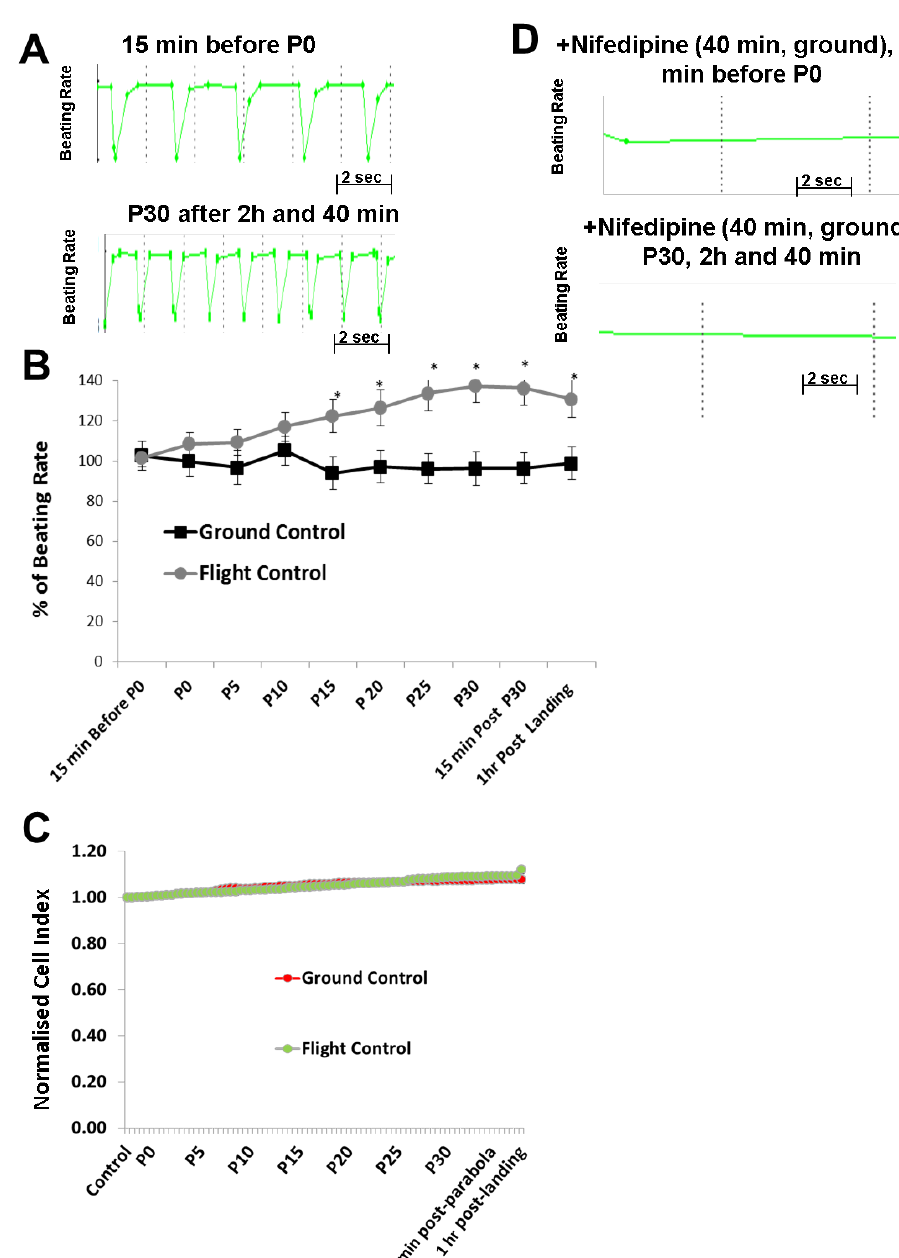
Figure 2. Analysis of the beating rate (BR) of human cardiomyocytes (hCMs) during parabolic flights. ( A ) Representative BR pattern of hCMs at a timepoint 15 min (1 g ) before starting the first parabola (P0) and after 31 parabolas (P30). ( B ) Data from three independent parabolic flight experiments (each executed in triplicate), as well as data collected from the 1 g ground experiment carried out in parallel. The BR values were normalized by setting the control pre-parabola flight or the ground control value to 100% (mean ± SEM; n = 9, * p < 0.05 for control versus parabolic flight experiment values). ( C ) Parallel monitoring of the cell viability expressed as cell index (CI) values. The CI values were normalized by setting the control values to 1. ( D ) Representative BR patterns of hCMs treated on the ground (1 g ) with nifedipine (1 µ M) 40 min before starting P0 and after P30. In this case, no BR was observed before P0 or after P30 because of complete inhibition of the L-Type Ca 2 + Channel. SEM, standard error of the